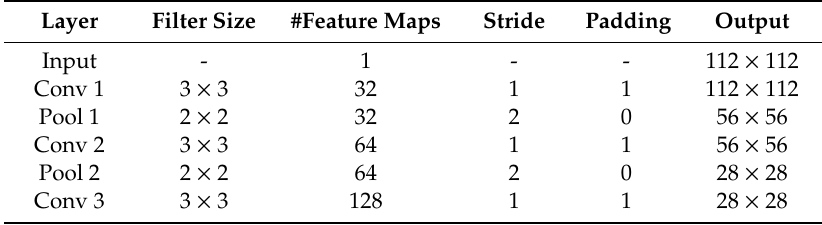
Table 1. Architecture of the deep convolutional autoencoder